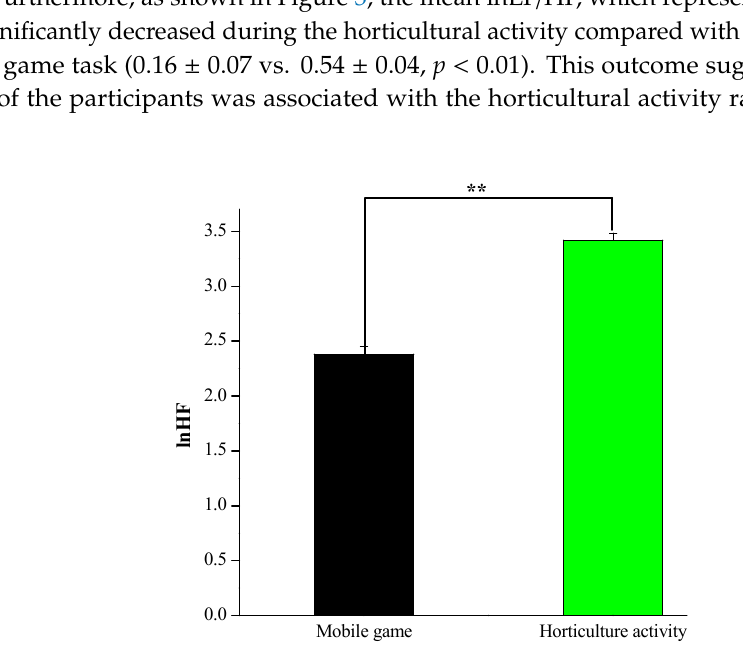
Figure 2. High-frequency band (lnHF) scores during the 5 min experimental period; n = 26, mean ± SE, ** p < 0.01 determined by the paired t -test.